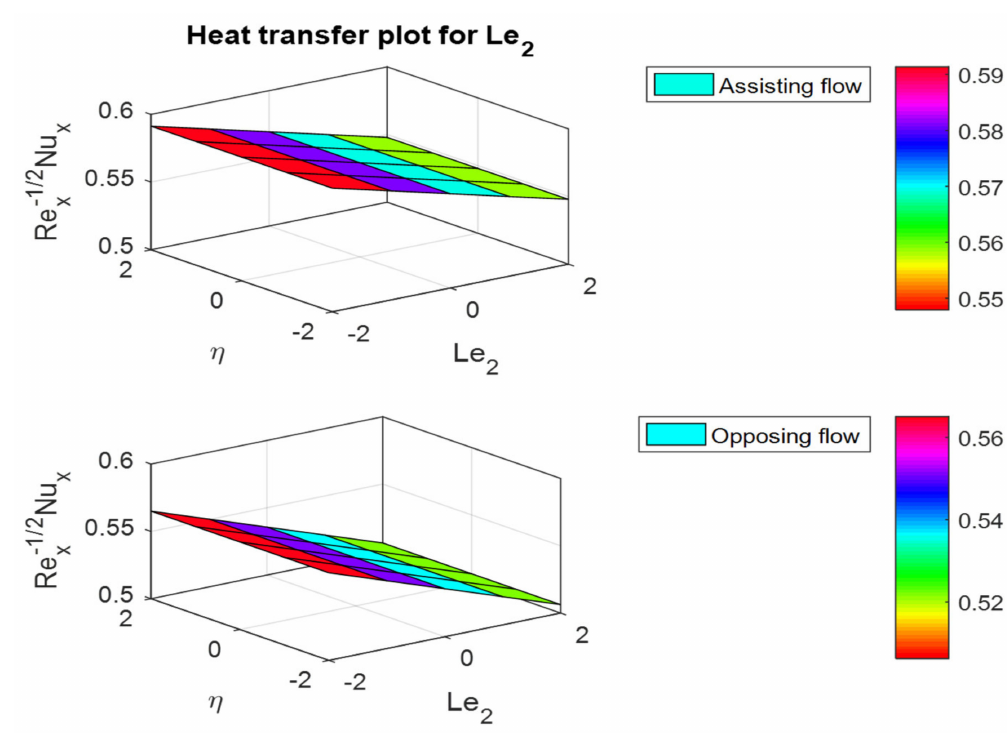
Figure 42. Surface plots for the θ (cid:48) ( 0 ) for dissimilar values of Le 2 .